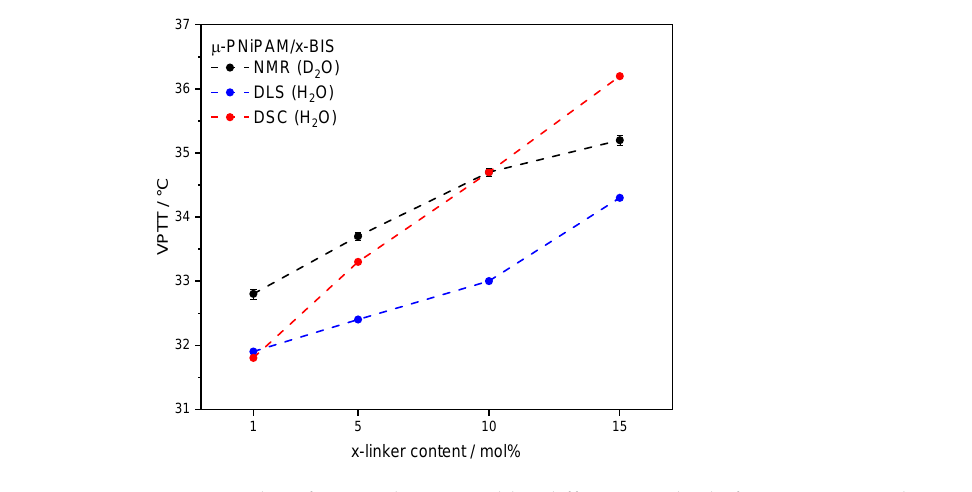
Figure 3. Plot of VPTT determined by different methods for neat microgels containing different amounts of crosslinker.